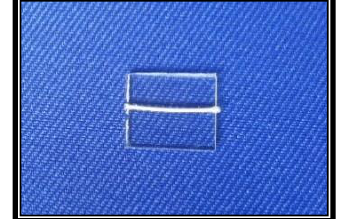
Figure 2: Wire sample fixed on a small